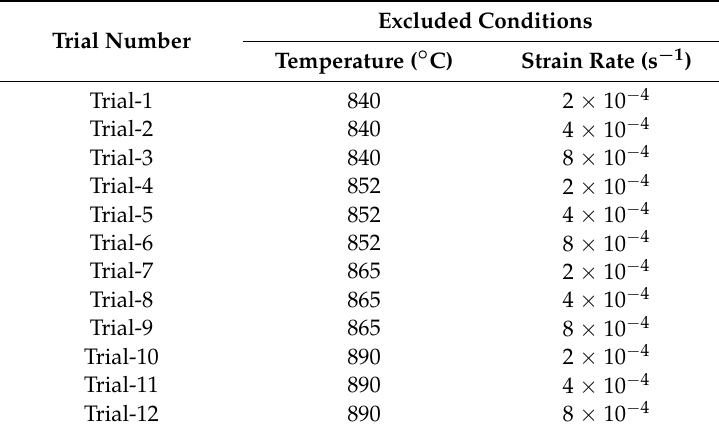
Table 4 . The excluded conditions in trial datasets. Table 4. The excluded conditions in trial